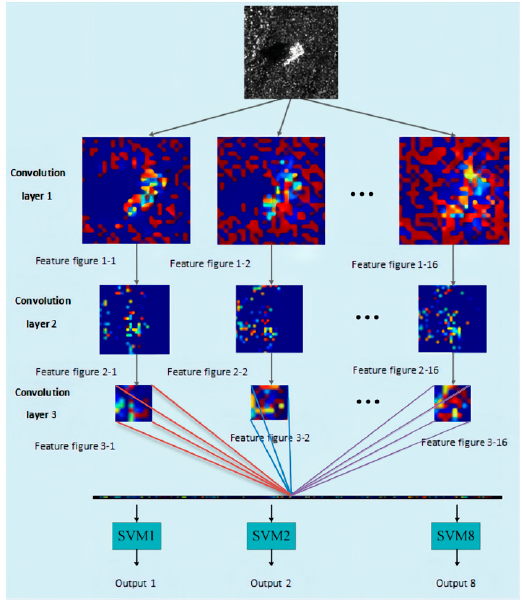
Figure 2. CAE + SVM model structure.